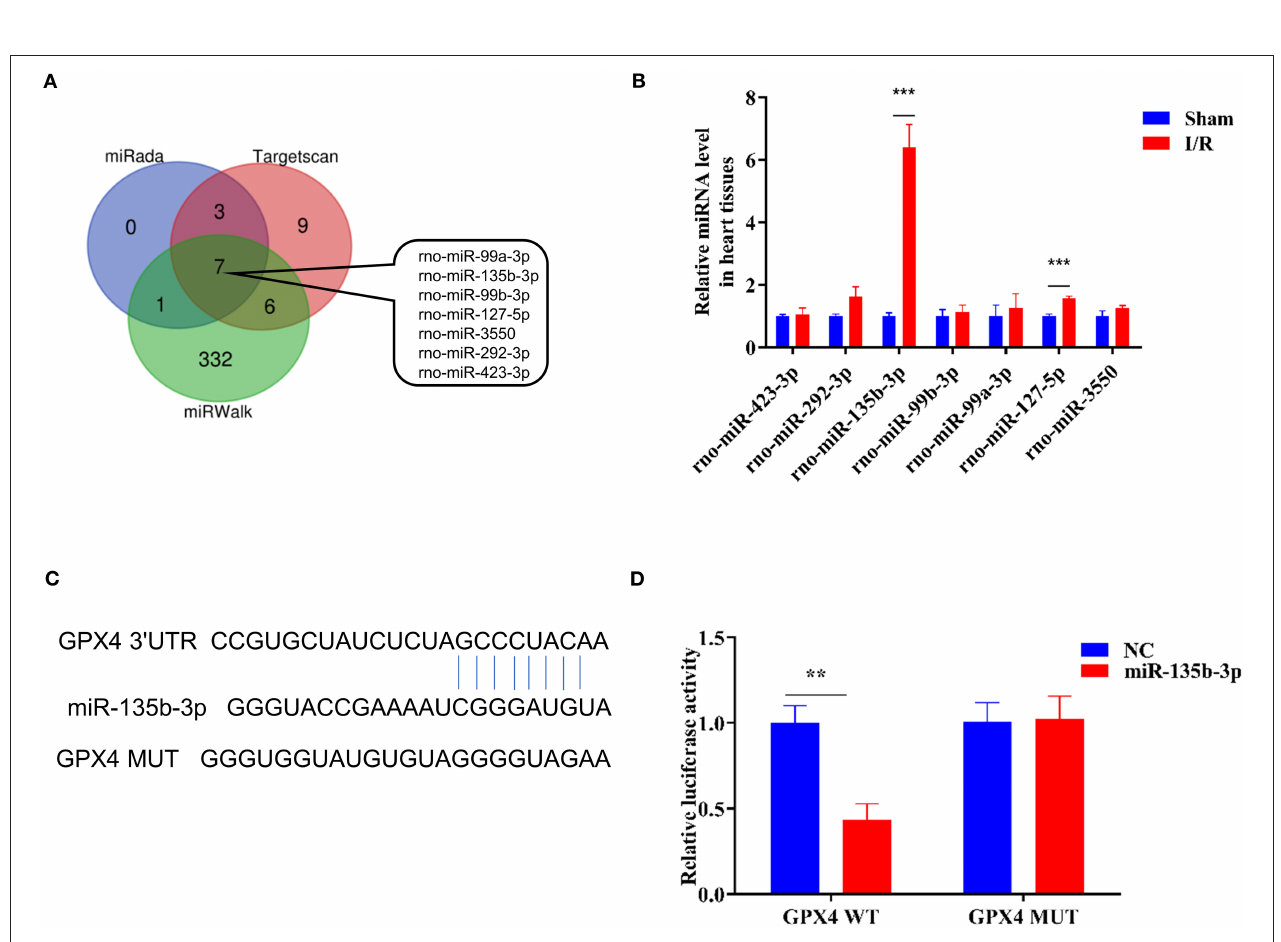
FIGURE 1 | change in ferrous iron levels in the myocardial tissues of sham and I/R rats. Scale bar = 400 µ m. (D,E) Western blotting was used to detect the levels of GPX4, FTH1, NOX1, ASCL4, and COX2 in sham and I/R rat myocardial tissues; quantitative analysis of the protein levels is shown in E. (F) RT-qPCR analysis was used for determining the GPX4, FTH1, NOX1, ASCL4, and COX2 mRNA levels. (G–J) LV short-axis view by transesophageal echocardiography in M-mode. *** p < 0.001, ** p < 0.01, * p < 0.05. * denotes the difference of the I/R group compared with the sham group. Error bars represent the mean ± SD of the experiments in triplicates.